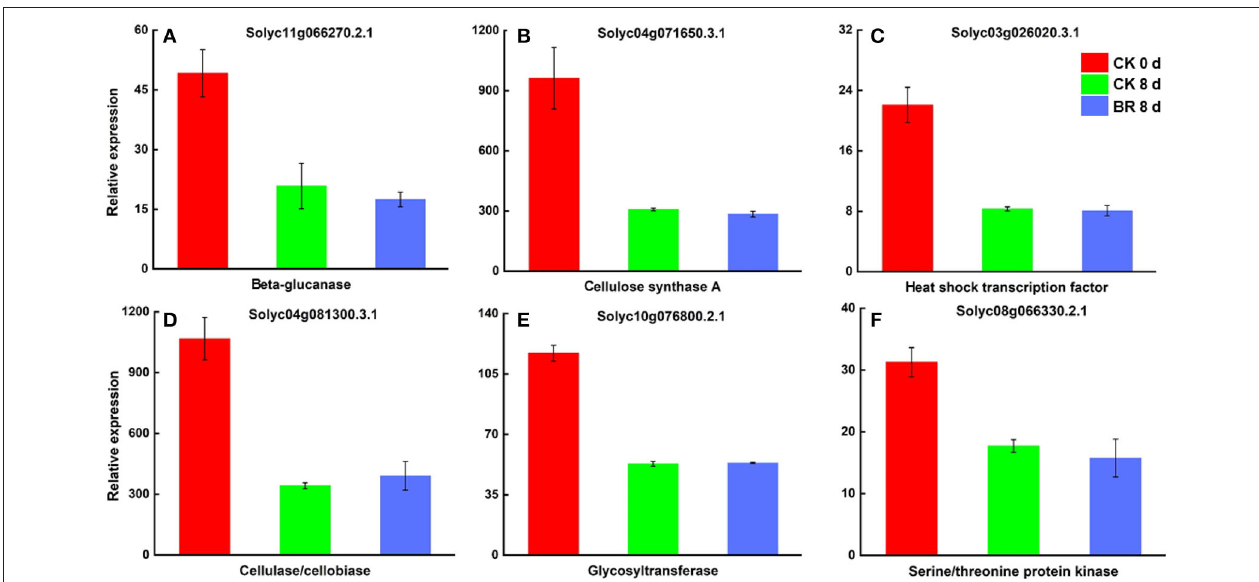
FIGURE 7 | Differentially expressed proteins in tomato fruit CI process regulated by BR. (A) Relative expression of beta-glucanase (BGL). (B) Cellulose synthase A (CESA). (C) Heat shock transcription factor (HSF). (D) Cellulase/cellobiase (CelA1). (E) Glycosyltransferase (GTF). (F) Serine/threonine-protein kinase (STK).